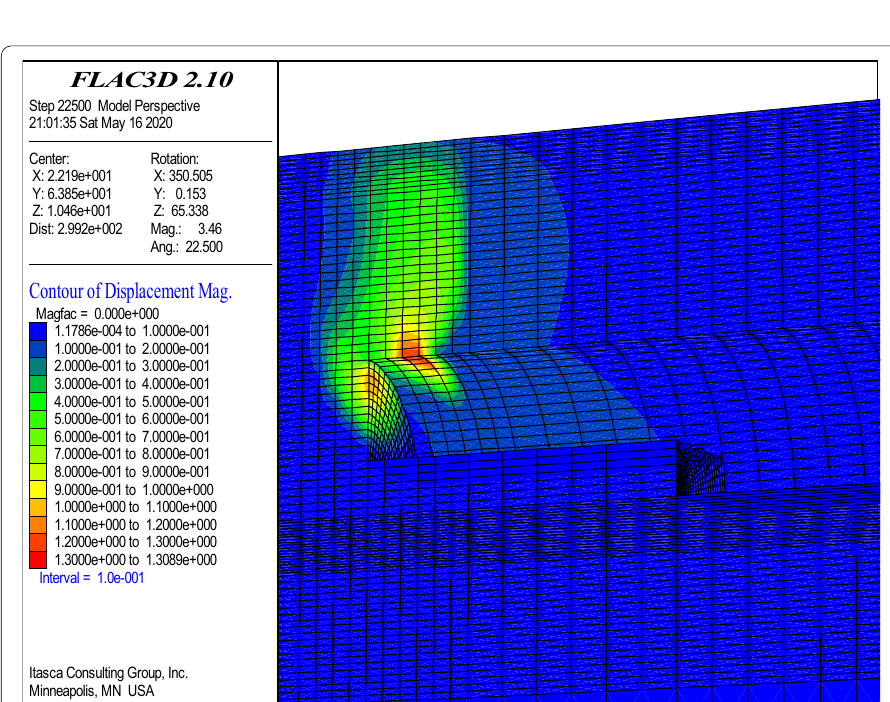
Fig. 18 Displacement in the Y direction